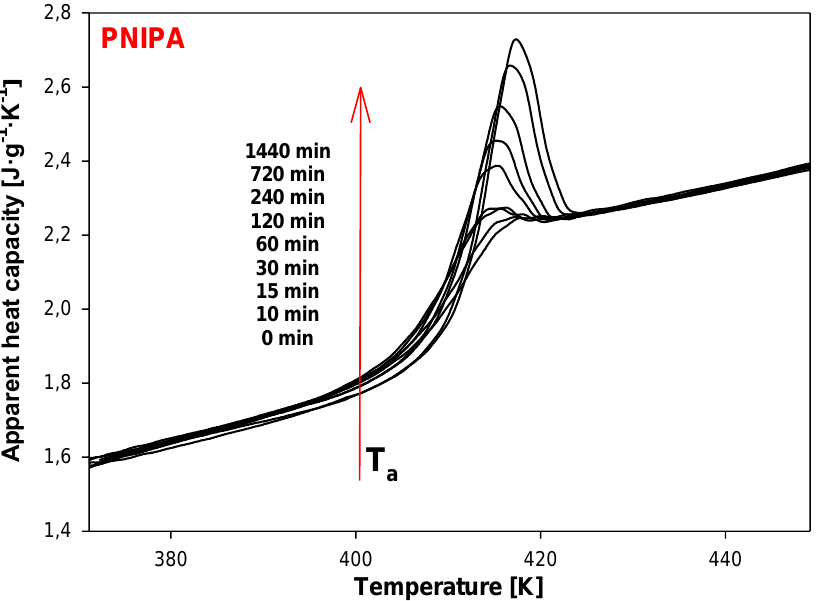
Figure 12. Isothermal aging of poly( N -isopropylacrylamide) at the aging temperature, T a = 400.15 K after different aging time, 0 – 1440 min obtained based on temperature-modulated differential scanning calorimetry (TMDSC) (underlying heating rate: q = 3 K/min, modulation amplitude: A = 1.5 K, and modulation period: p = 60 s).